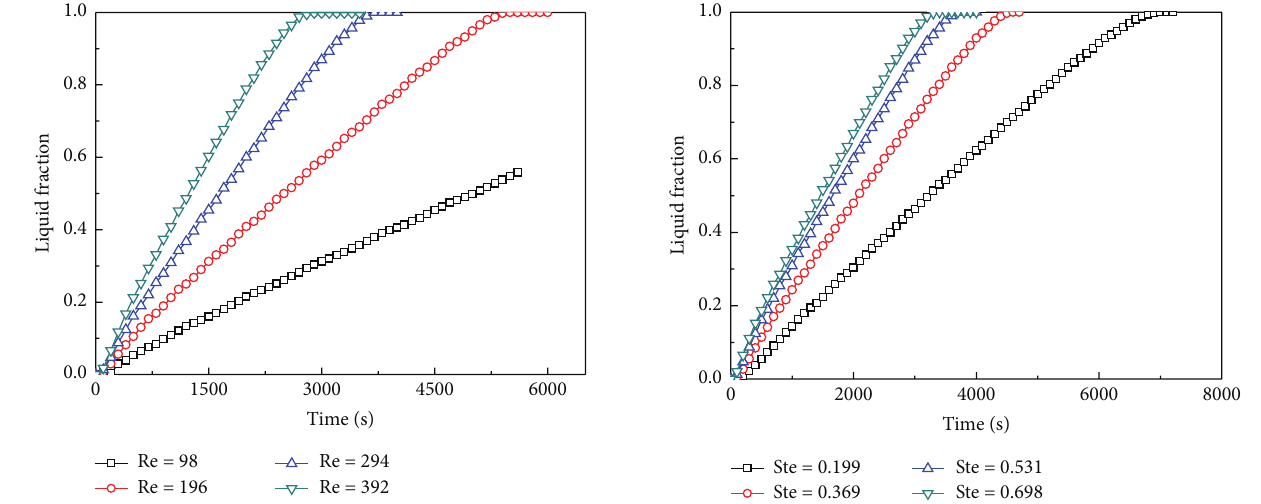
Figure 16: The liquid fraction of the PCMs as a function of time during the charging process at different Re number.